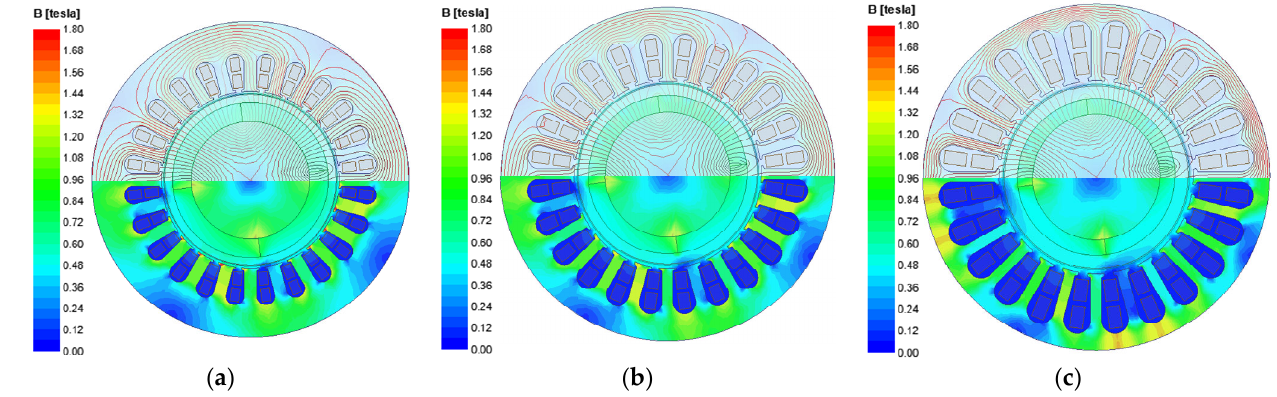
Figure 11. Magnetic flux density and lines distributions under different cases at rated load: ( a ) Case 1; ( b ) Case 2; ( c ) Case 3. The line ‐ to ‐ line back ‐ EMF and its Fourier transform results in three cases under no ‐